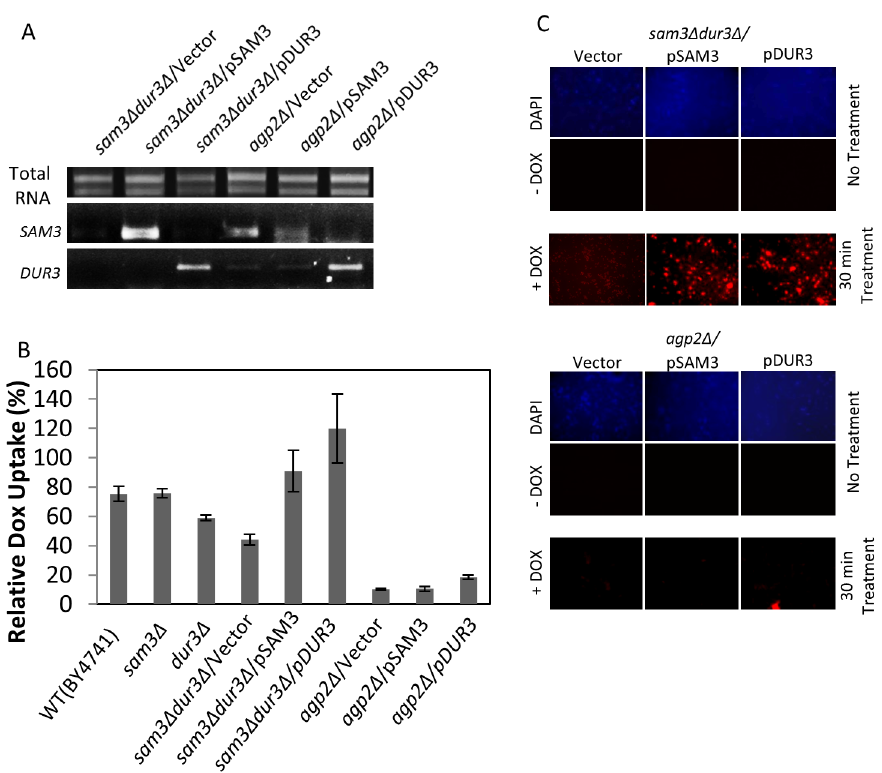
Fig 4. A multicopy plasmid carrying either the entire SAM3 or DUR3 gene rescues DOX uptake in the sam3 Δ dur3 Δ double mutant but not in the agp2 Δ single mutant. (A) RT-PCR analysis showing the expression level of SAM3 and DUR3 in the sam3 Δ dur3 Δ and the agp2 Δ mutants with the indicated plasmids. Total RNA (1 μ g) was reverse-transcribed and the expression level of either SAM3 or DUR3 was assessed from the resulting cDNA using gene specific primers [5]. (B) DOX uptake is mediated by the Sam3 and Dur3 transporters and depends on Agp2 function. The multicopy plasmid pSAM3 or pDUR3 carrying the entire SAM3 or DUR3 gene, respectively, with the endogenous promoter was introduced into either the sam3 Δ dur3 Δ double mutant or the agp2 Δ single mutant and the resulting transformants monitored for DOX uptake in low YNB using FACS analysis. (C) Epifluorescent microscopy showing that either pSAM3 or pDUR3 restores DOX uptake to the sam3 Δ dur3 Δ double mutant, but not to the agp2 Δ mutant. Microscopy was conducted as in Fig